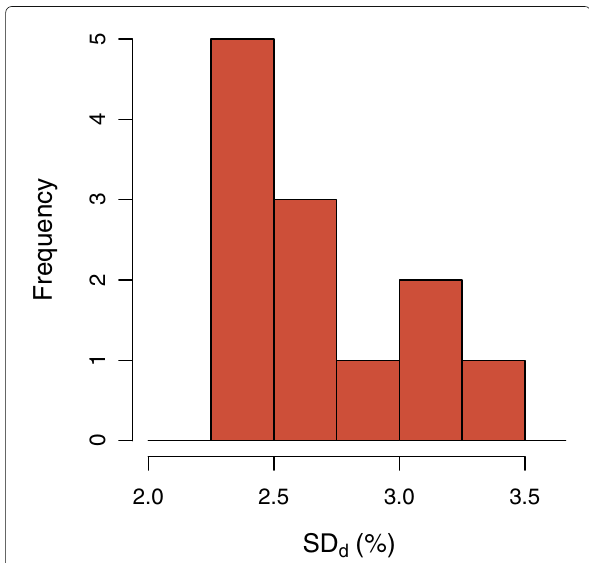
Fig. 6 Histogram of observer performance contribution to the interobserver variability, described by SD d (Eq. 4), the standard deviation of the distribution of fractional deviations (cid:2) BSUV dp (Eq. 1) from observer mean for the respective patient grouped by observer as illustrated in Fig. 5